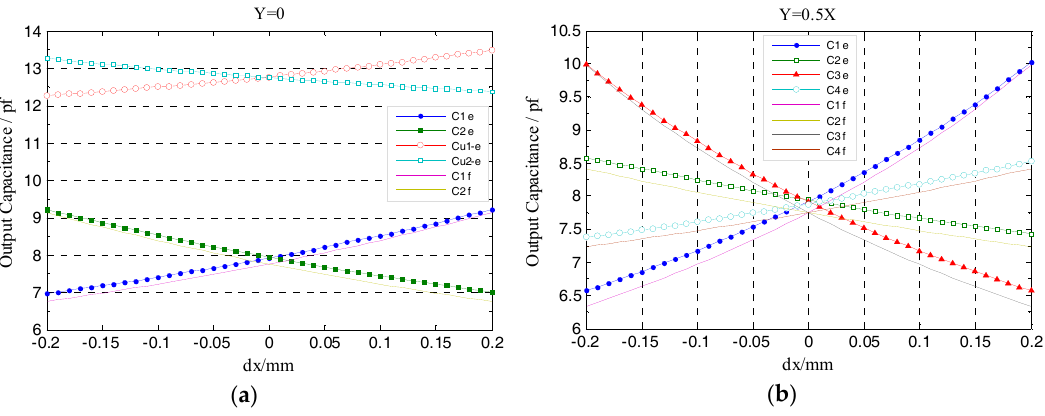
Figure 22. Comparison of experimental and simulation values of the radial cylindrical electrode output capacitance: ( a ) Comparing with the previously developed CCS (2-DOF); ( b ) The comprehensive comparison of the single cylindrical electrode output capacitance. The Cie , Cui-e in the curve diagram denote the actual measured values of the T-type CS and the previously developed CCS respectively.